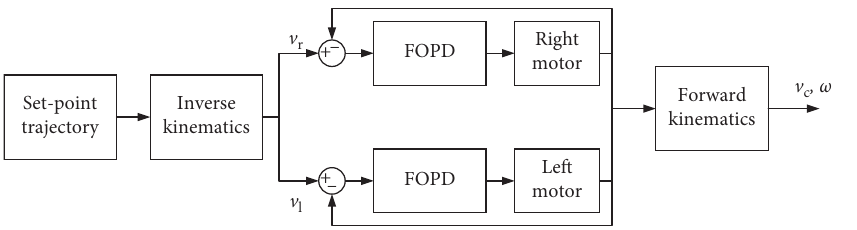
Figure 3: XQ WMR control